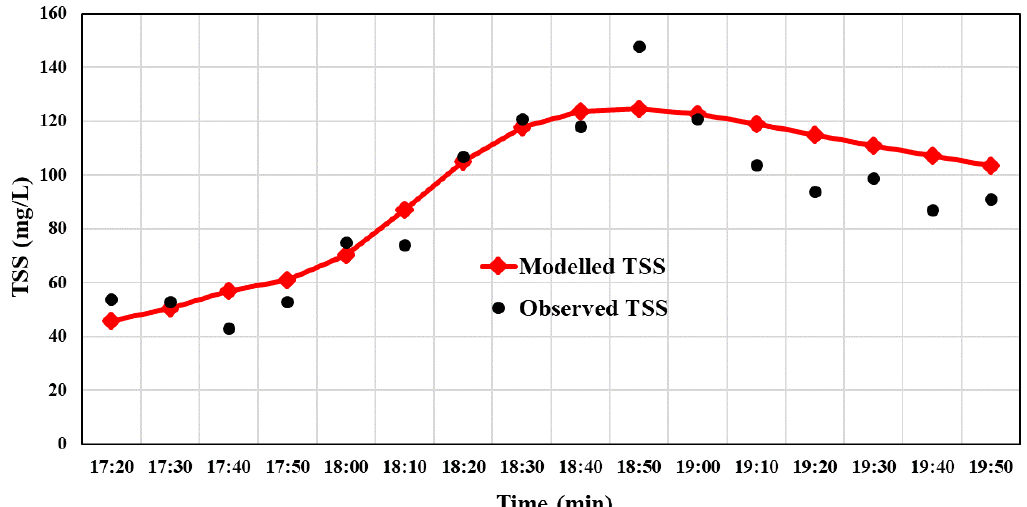
Figure 7. Total suspended sediments (TSS) calibration result.